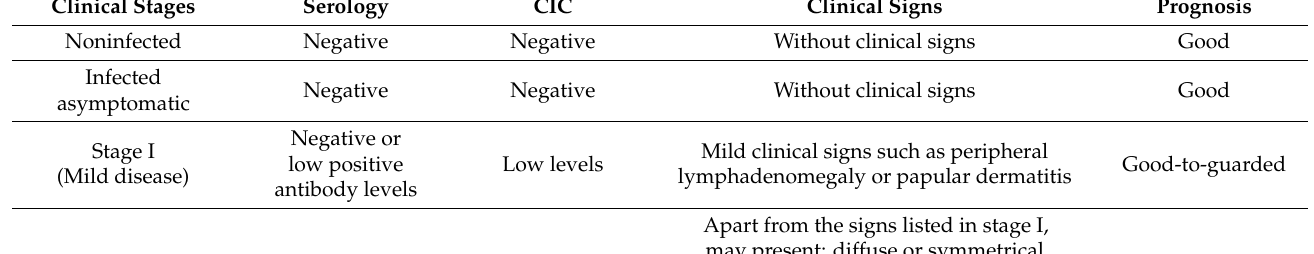
Table 1. CanL classification reflecting serological status, CIC levels, clinical signs and prognosis for each stage (based on LeishVet group guidelines for the practical management of CanL [20], and on published data regarding the relationship between circulating immune complexes (CIC) levels and the progression of CanL in naturally infected dogs [15]). Clinical Stages